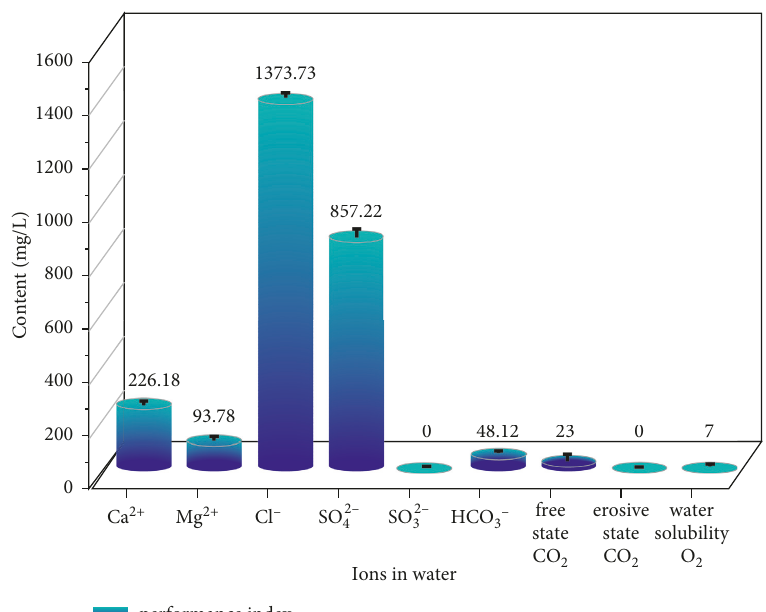
Figure 1: The chemical performance index of roadway roof